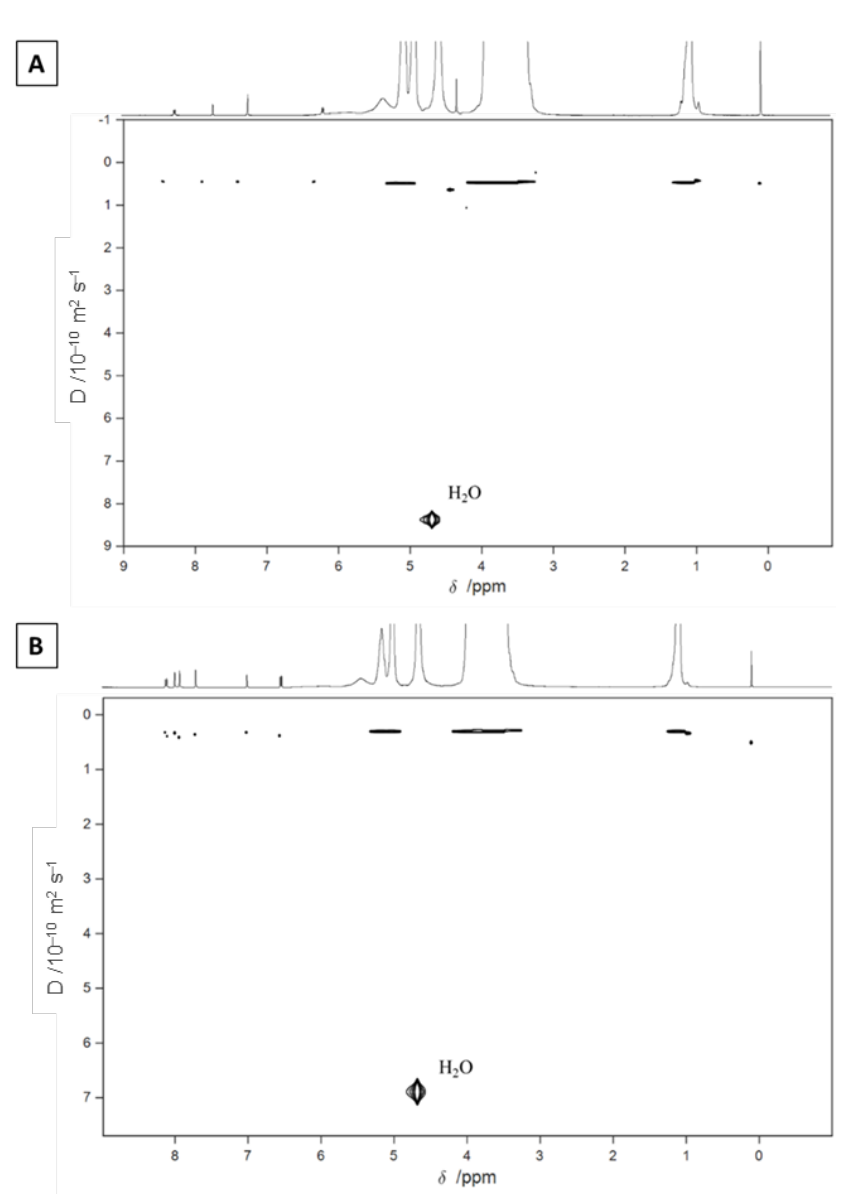
Figure 4. 1 H DOSY experiments for 5-MOP/HP- β -CD ( A ) and PSO/HP- β -CD ( B ) (500 MHz, D 2